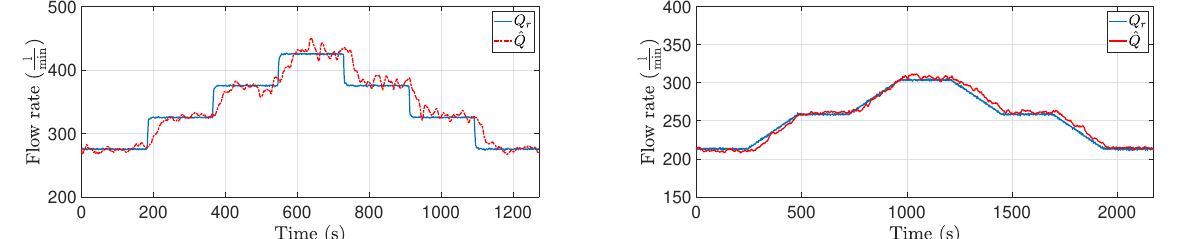
Figure 15: The reference Q r and estimated ˆ Q fluid flow rates for the non-Newtonian drilling fluid.